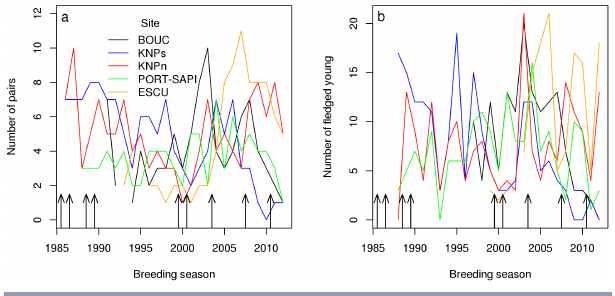
Fig. 6 . Model-averaged predictions of the number of Piping Plover ( Charadrius melodus melodus ) nesting pairs (a) and fledged young (b) at the study sites for a given breeding season in relation to the occurrence of storms three years earlier. Error bars denote 95% unconditional confidence